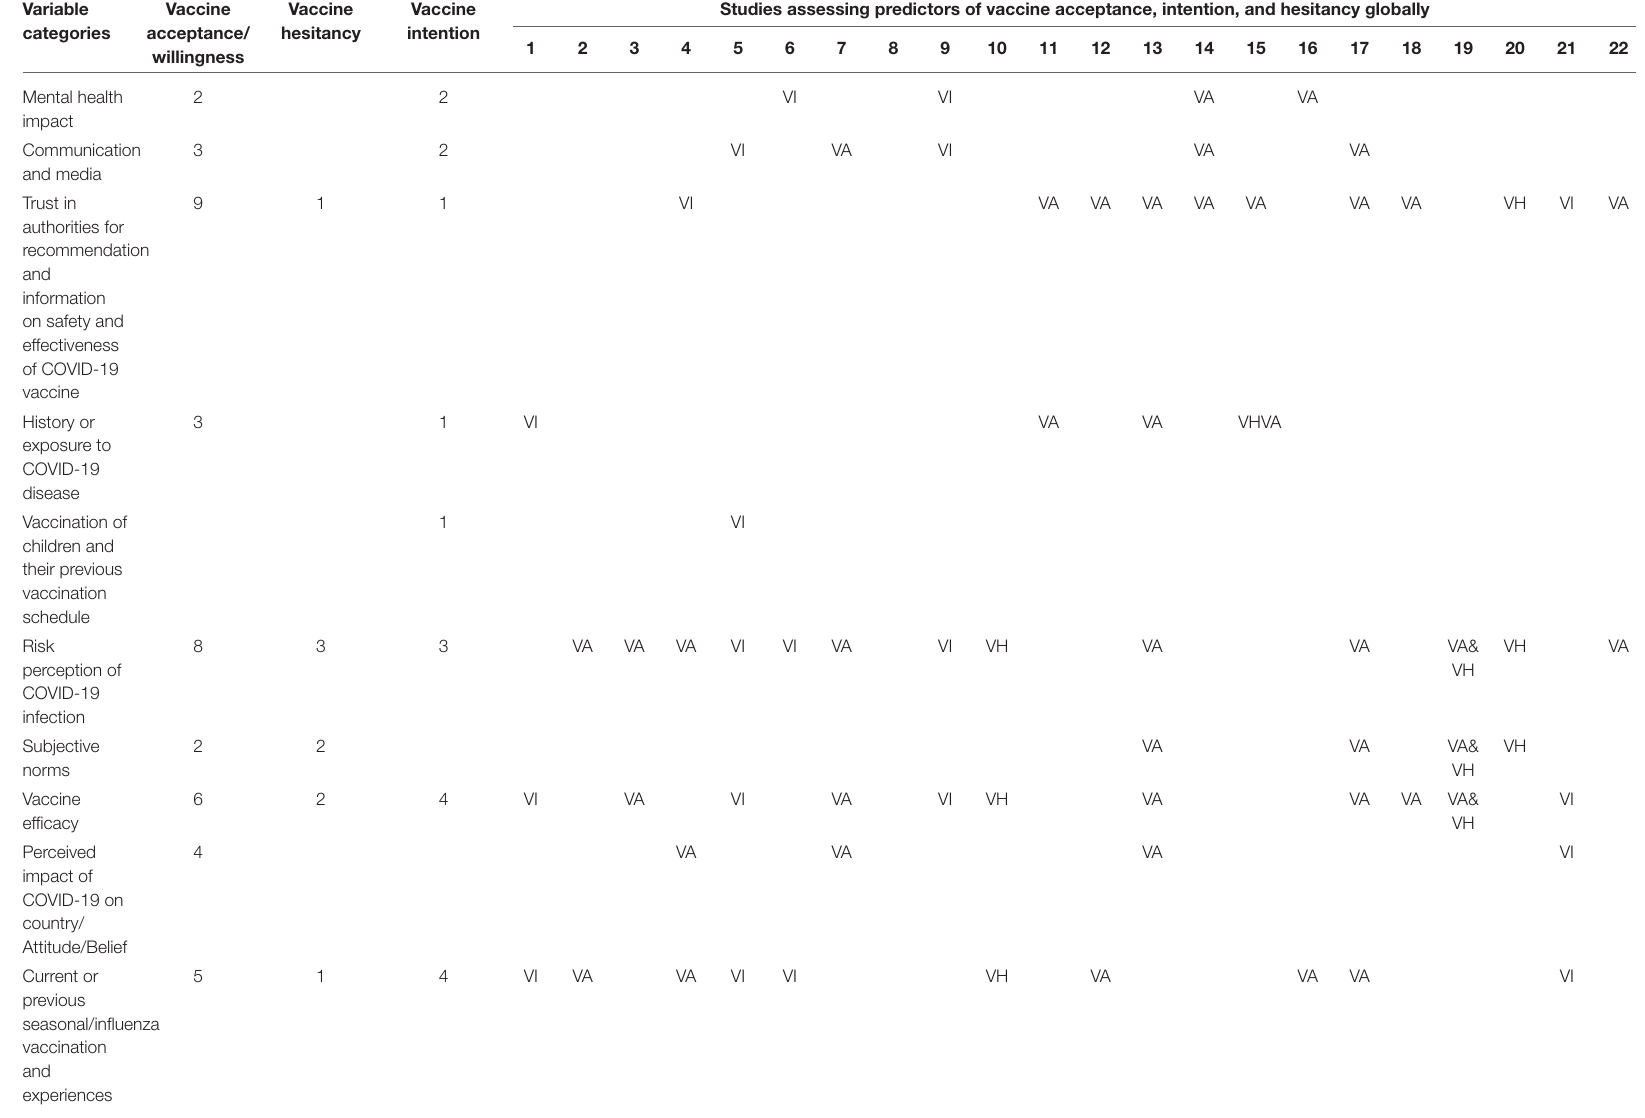
TABLE 4 | Variables influencing COVID-19 vaccine acceptance, intention, and hesitancy. Variable